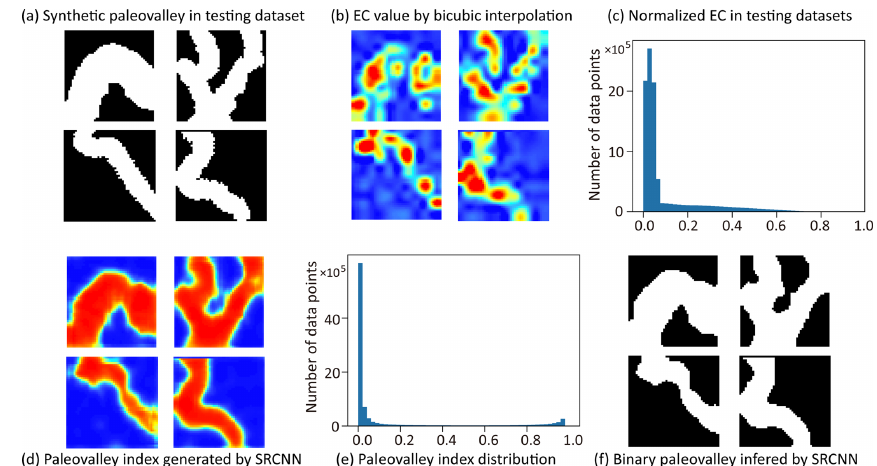
Figure 5. (a) DEM-generated synthetic paleovalley used as reference image in testing the SRCNN; (b) normalized electrical conductivities corresponding to the paleovalleys following (c) a skewed distribution (based on 4000 images in the test dataset). (d) Paleovalley index generated through processing EC images via the SRCNN; (e) bimodal distribution of paleovalley index (based on 4000 images in the test dataset); (f) the paleovalley index map converted into a binary paleovalley map by arbitrarily selecting the paleovalley index threshold as